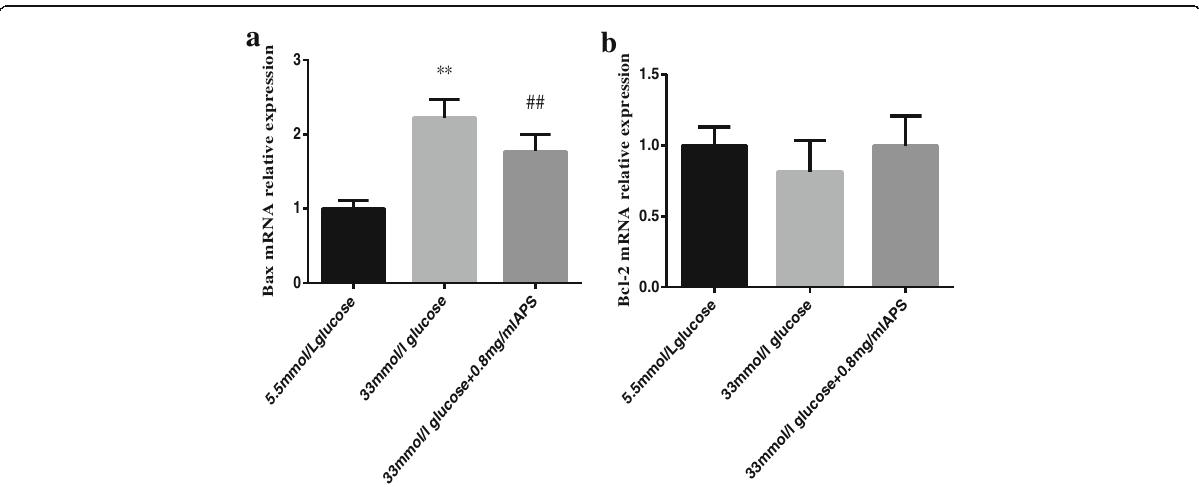
Fig. 6 APS modulated the mRNA expression levels of Bax and Bcl-2. H9C2 cells were pre-incubated with/without APS for 24 h and then treated with 33 mmol/L glucose for 24 h. The expression of GAPDH was measured as an internal control. a . the relative mRNA expression levels of Bax in different groups. b . the relative mRNA expression levels of Bcl-2 in different groups. Data were expressed as Mean ± SD. ** P < 0.01 versus 5.5 mmol/L glucose group; ## P < 0.01 versus 33 mmol/L glucose